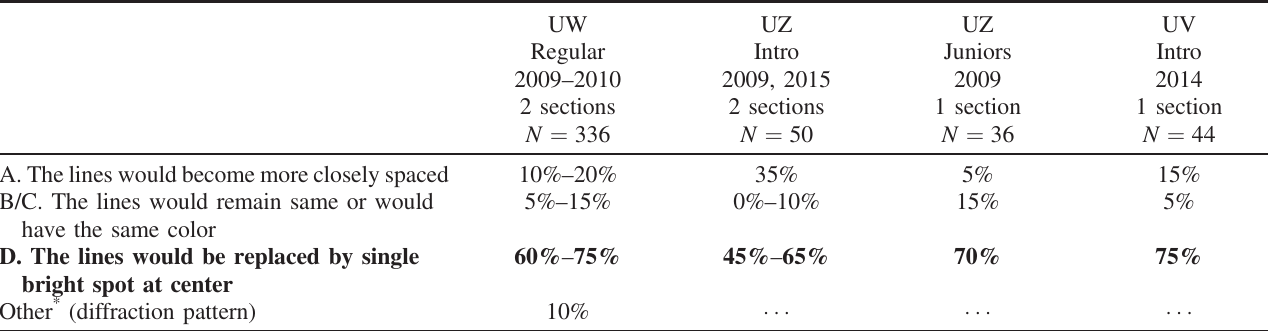
TABLE II. Results from Task 2, in which students were asked how the discrete spectral line pattern would change if the prism were removed from the optical set-up. The correct answer is shown in